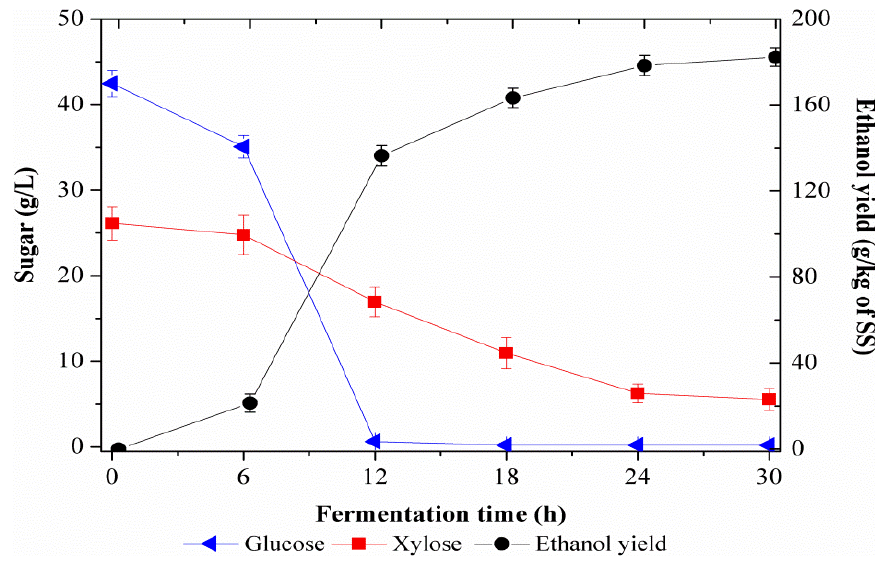
Figure 3. Sugar and ethanol concentration changed during SSCF with a Z. mobilis TSH-ZM-01 in 10 g NaOH pretreated SS under optimal